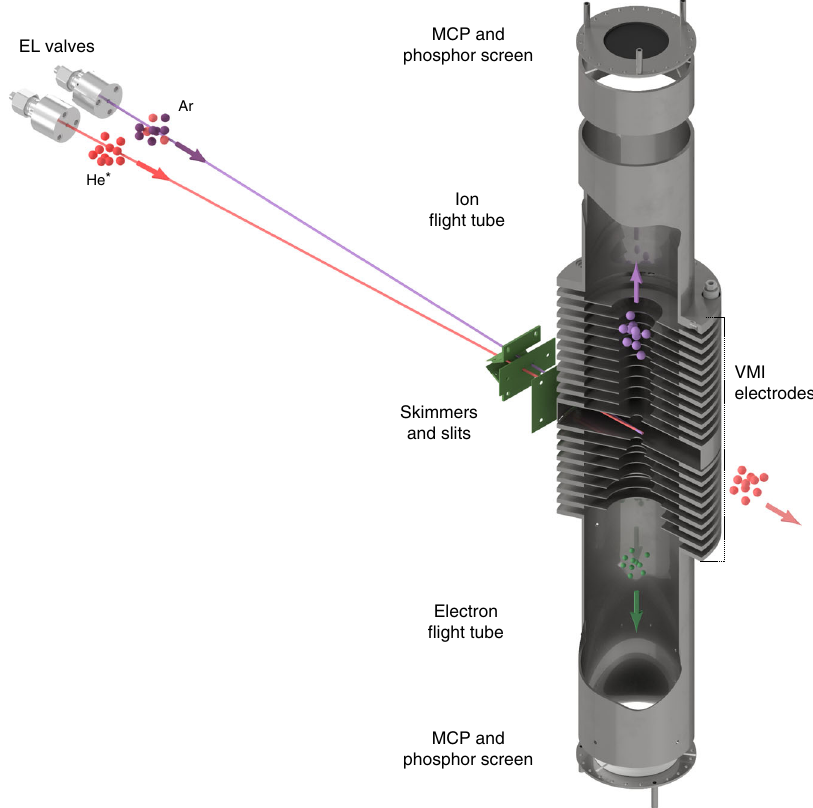
Fig. 2 Experimental setup. Supersonic beams of metastable He (red) and ground state argon (purple) are shaped by a set of skimmers and slits before colliding in the center of a double VMI apparatus. Product ions and electrons are accelerated and their velocity is imaged by a set of 19 open-aperture electrodes followed by two free- fi eld fl ight tubes. For both ions and electrons, arrival times and positions are detected by micro channel plate (MCP) detectors followed by phosphor